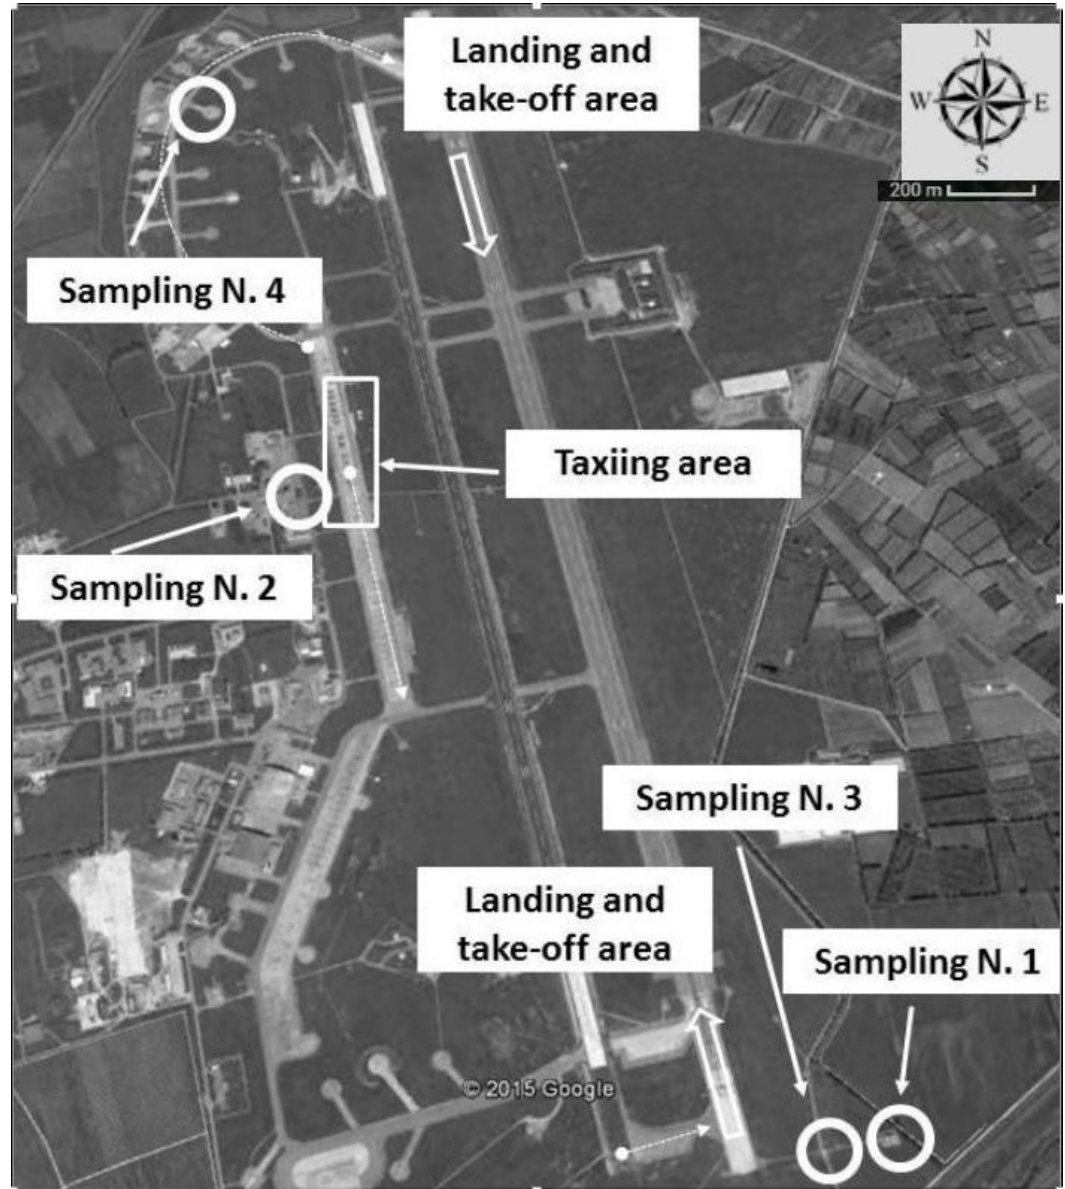
Figure 2. Sampling sites at the military airport.